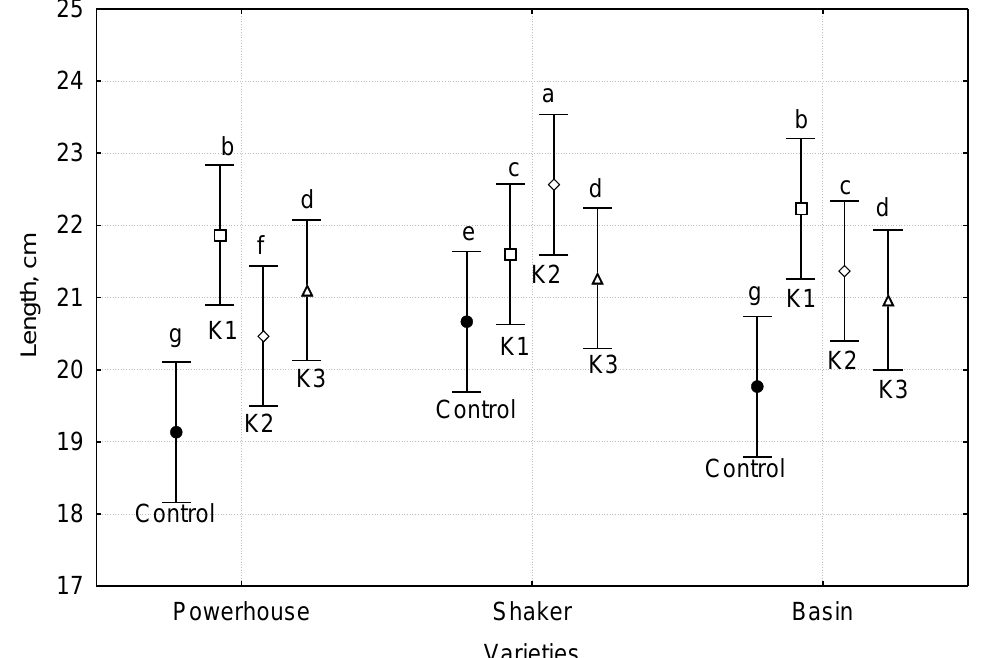
Figure 4. Changes in cobs length with 95% confidence intervals relative to the number of light exposures and respective cultivars (mean of two years). Means with the same letter are not significantly different from each other ( p < 0.05—ANOVA followed by Tukey test). Error lines represent ± standard deviation of the mean.